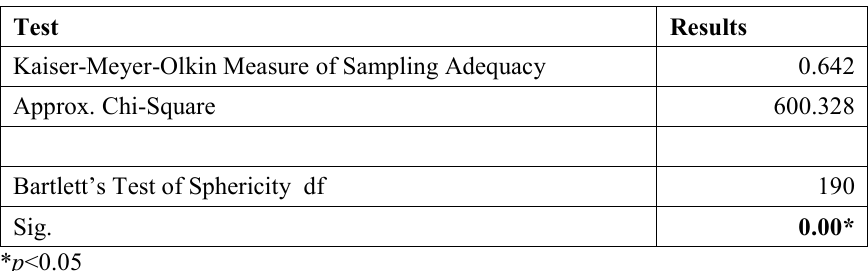
Table 2. Kaiser-Meyer-Olkin and Barlett’s Test